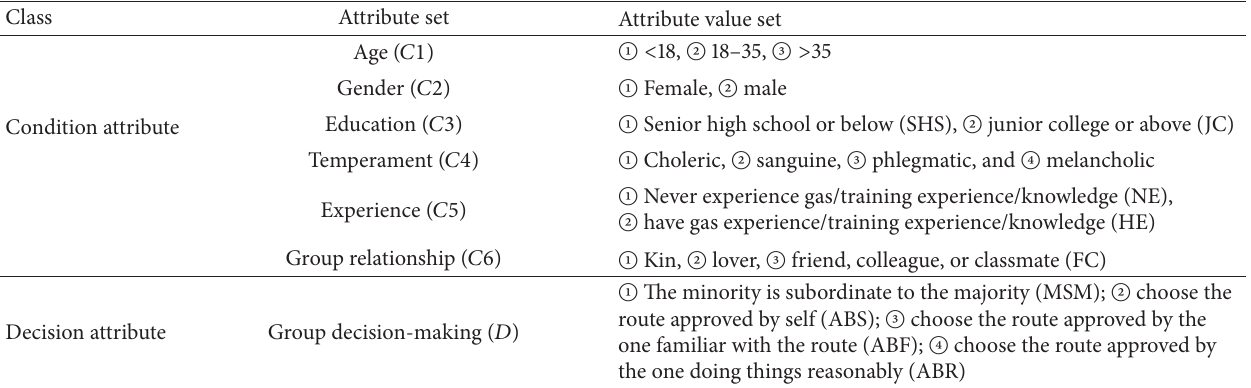
Table 2: The attribute set and attribute value